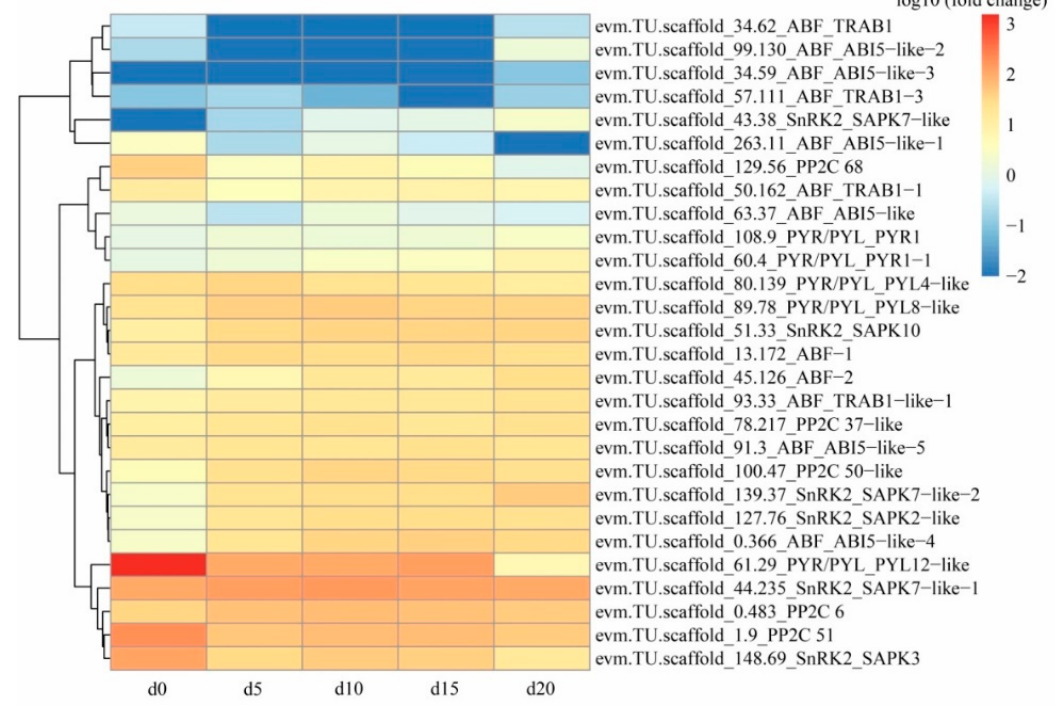
Int. J. Mol. Sci. 2021 , 22 , x FOR PEER REVIEW Figure 4. The heat map of expression levels of genes associated with abscisic acid (ABA) biosynthesis in Gastrodia elata on the initial (d0), 5th (d5), 10th (d10), 15th (d15), and 20th (d20) days of the coculture with Mycena sp. WM.